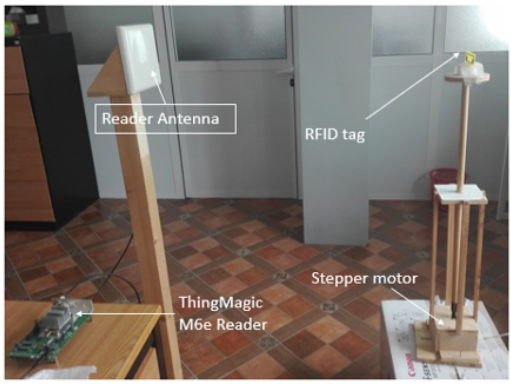
FIGURE 10: Read range measurement setup.